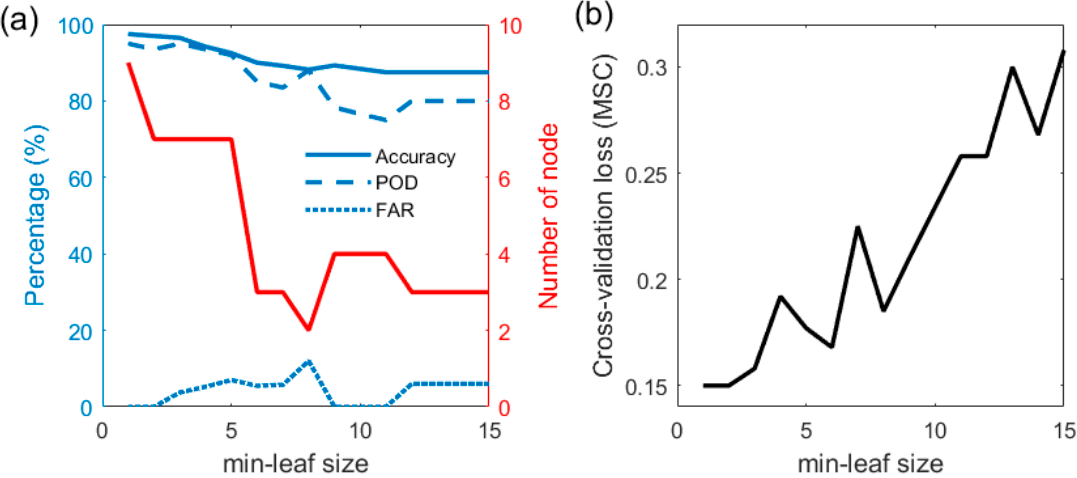
Figure 4. ( a ) Skill scores (blue lines) and the number of nodes (red line) at each minimum leaf size used in the decision-tree algorithm. ( b ) Distribution of cross-validation loss (mean misclassification rate) on the basis of the minimum leaf size using the k -fold cross-validation method.